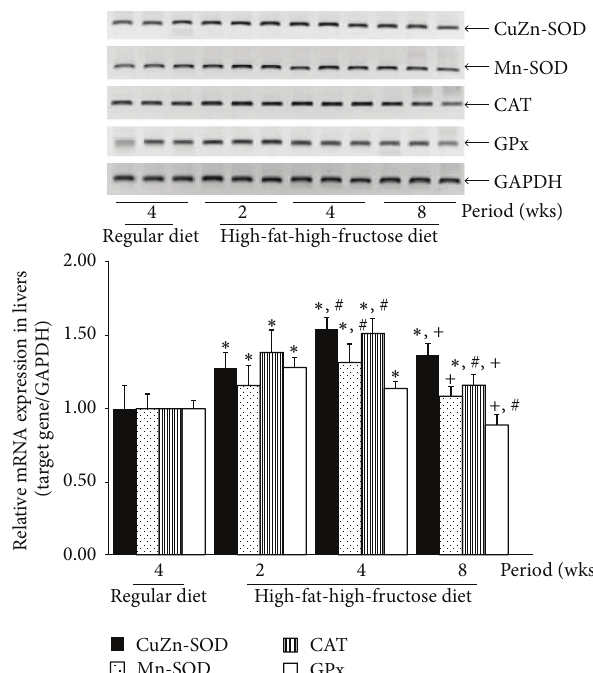
Figure 2: Effects of a high-fat, high-fructose diet on CuZn-SOD, Mn-SOD, CAT, and GPx mRNA expression in mouse livers. Mice were fed a commercial standard diet for 4 weeks, and a high-fat, high-fructose diet (HFFD) was administered intragastrically for 2, 4, or 8 weeks. A semiquantitative determination of the hepatic mRNA expression of certain genes was performed using pairs of primers specific to the investigated genes. The data are presented as the mean ± SD ( 𝑛 = 5 ). Significant differences were determined using a one-way analysis of variance (ANOVA) followed by Tukey’s post hoc test. ∗ 𝑝 < 0.05 versus the regular diet mice; # 𝑝 < 0.05 versus 2-week HFFD mice; + 𝑝 < 0.05 versus 4-week HFFD mice.